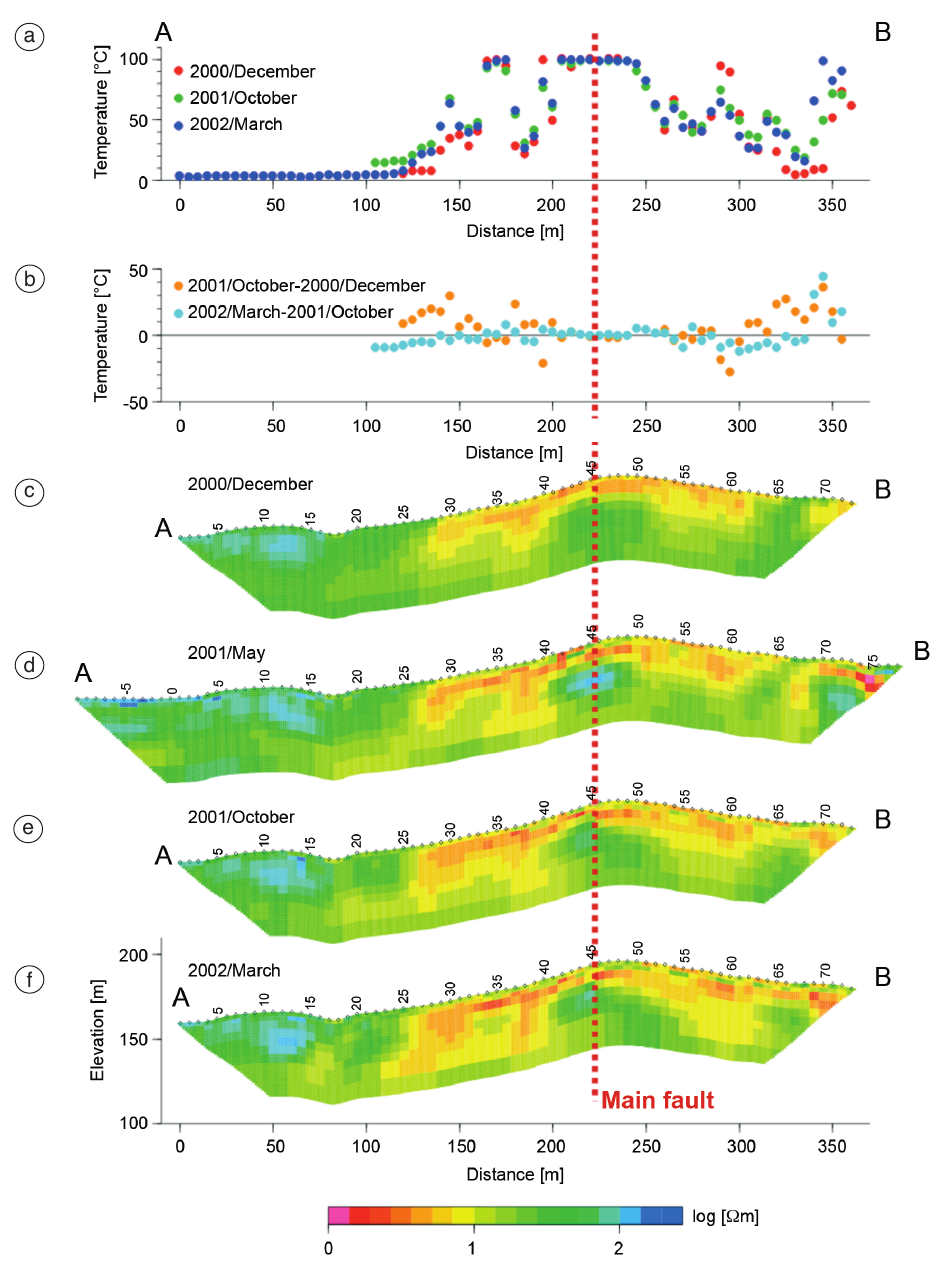
Fig. 5a-f. a) Ground temperature at a depth of 67 cm along the measurement line A-B shown in fig. 3; b) tem- poral variation of the ground temperature along the A-B line; c), d), e) and f) temporal variation of the resistiv- ity structure along the A-B line. Horizontal scale and position are common to all